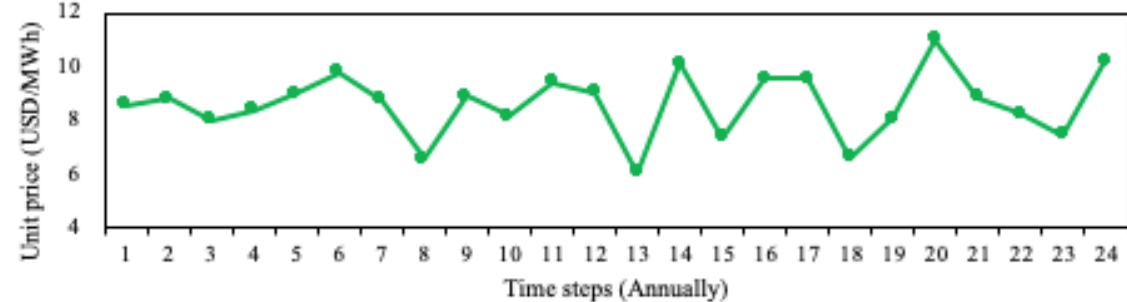
Figure 6. A single realisation of natural gas price simulation.